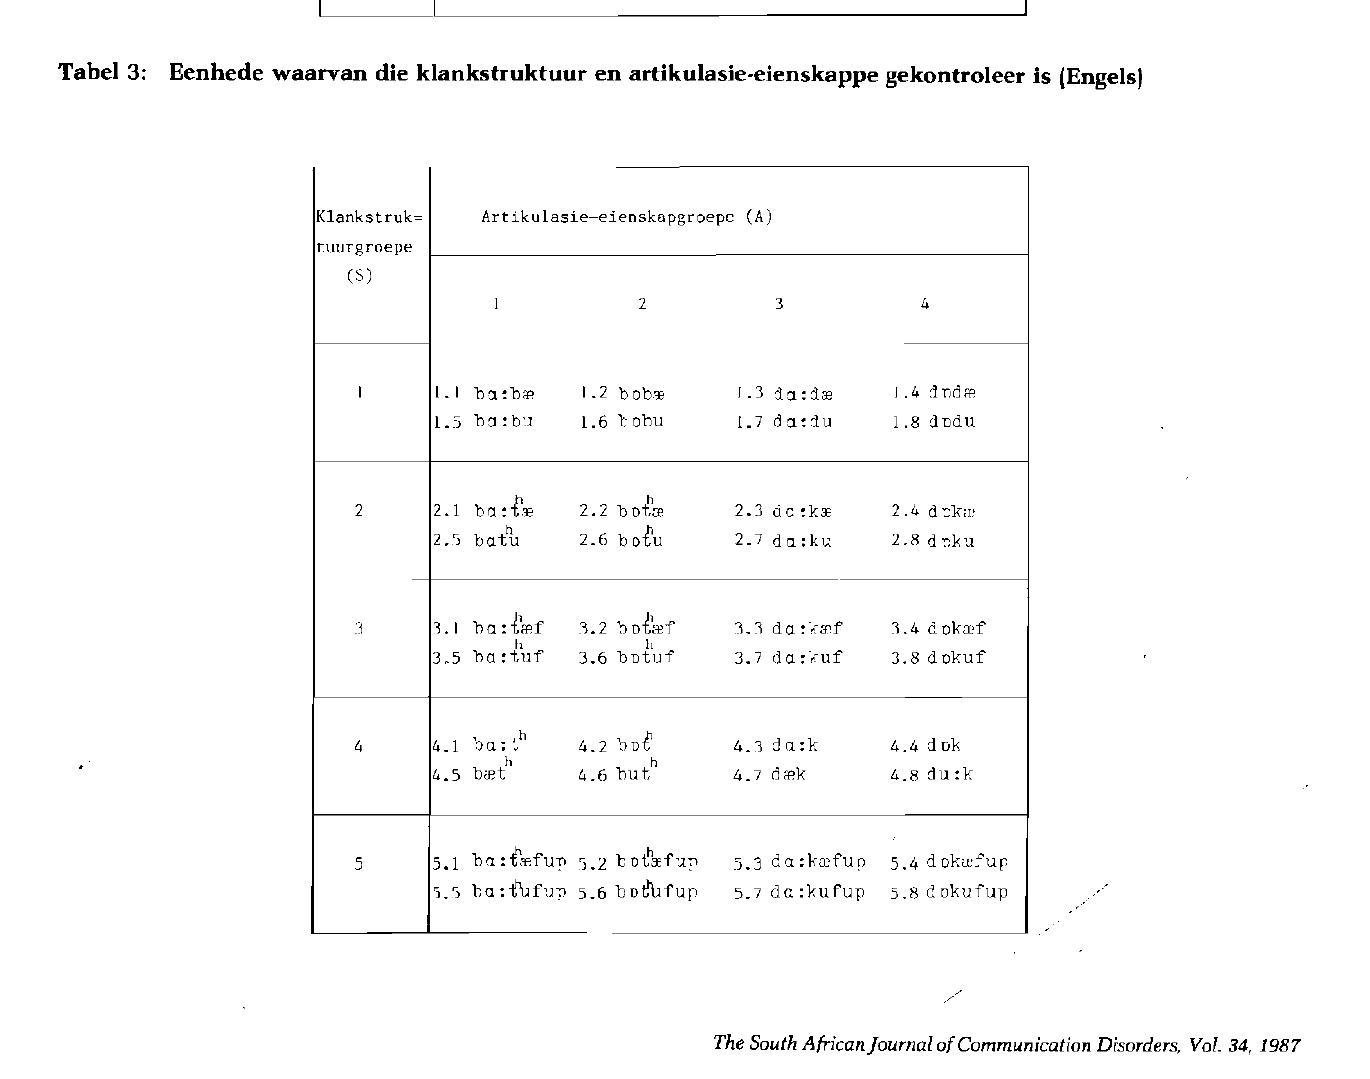
Tabel 3: Eenhede waarvan die klankstruktuur en artikulasie-eienskappe gekontroleer is